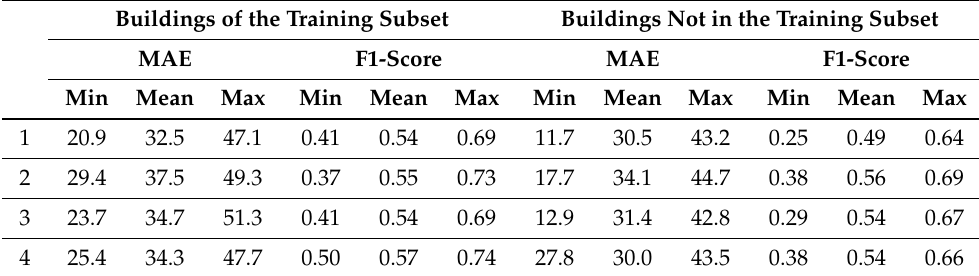
Table 5. Disaggregation results for different buildings of the REFIT dataset. Buildings of the Training